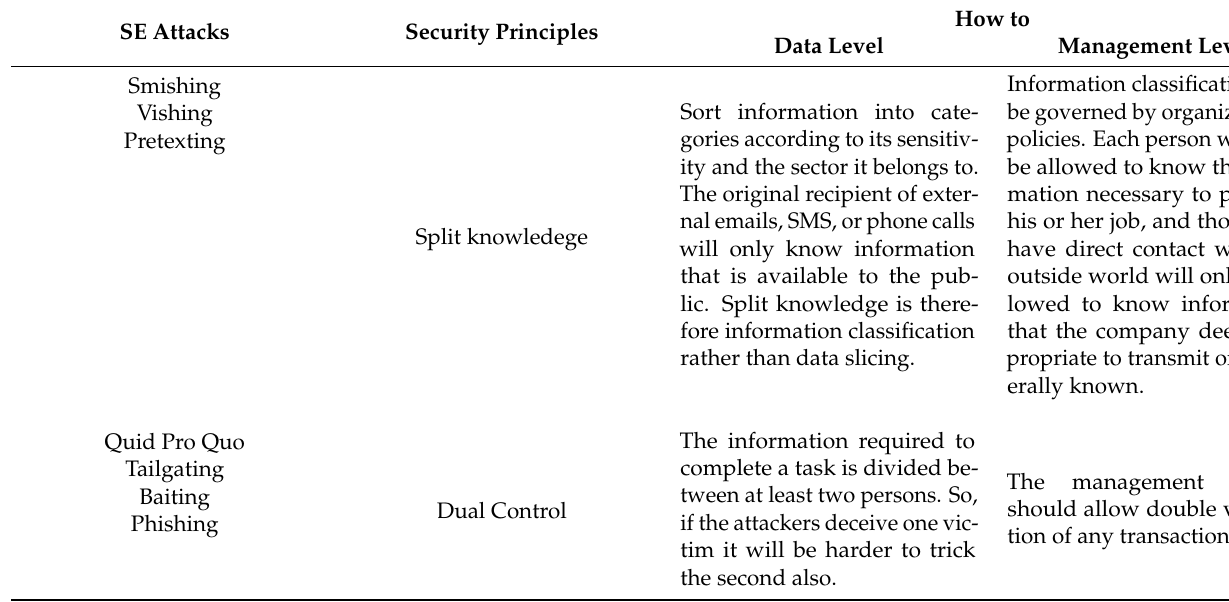
Table 1. Security principles ability to stop SE